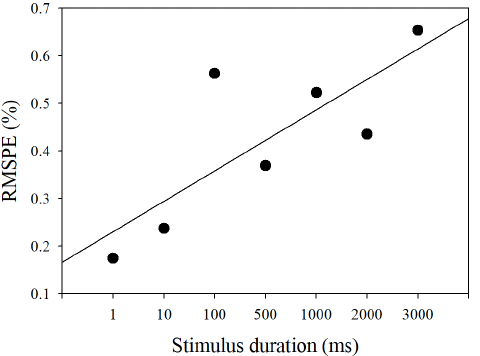
Figure 7. RMSPE of the simulated pupillary light reflex response under seven stimulus durations.